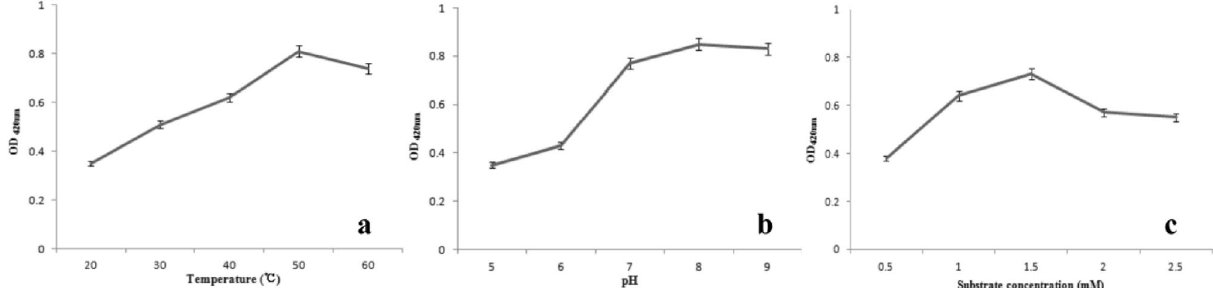
Figure 8. Optimization of reaction conditions of AgNPs. ( a ) Time on AgNPs biosynthesis by cell filtrate of Aspergillus sywdoii ; ( b ) pH; ( c ) substrate